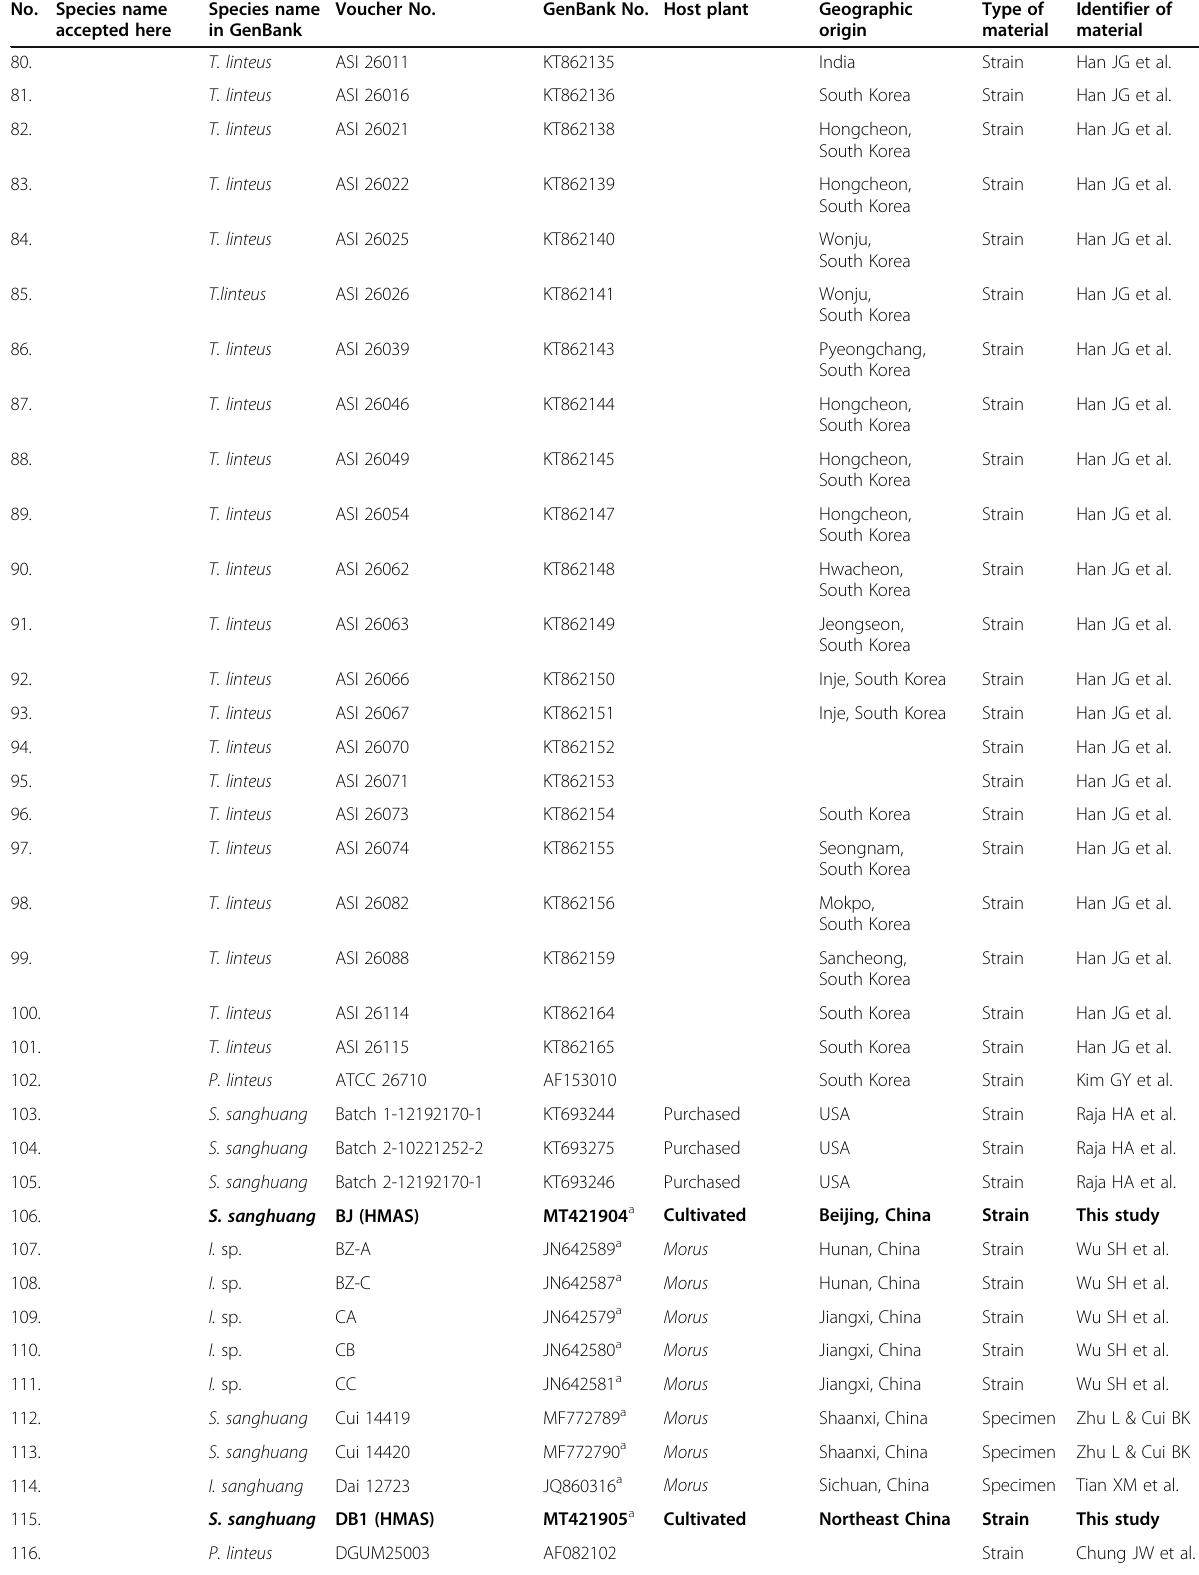
Table 1 Information of analyzed ITS sequences of Sanghuangporus